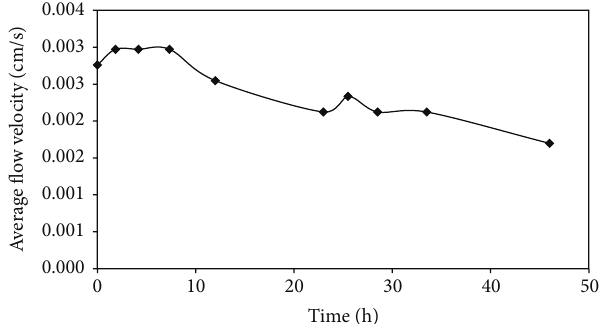
Figure 11: Relationship between 𝑘𝑡/𝑘0 and time in different layers under the hydraulic gradient of 0.25 (experiment 3).